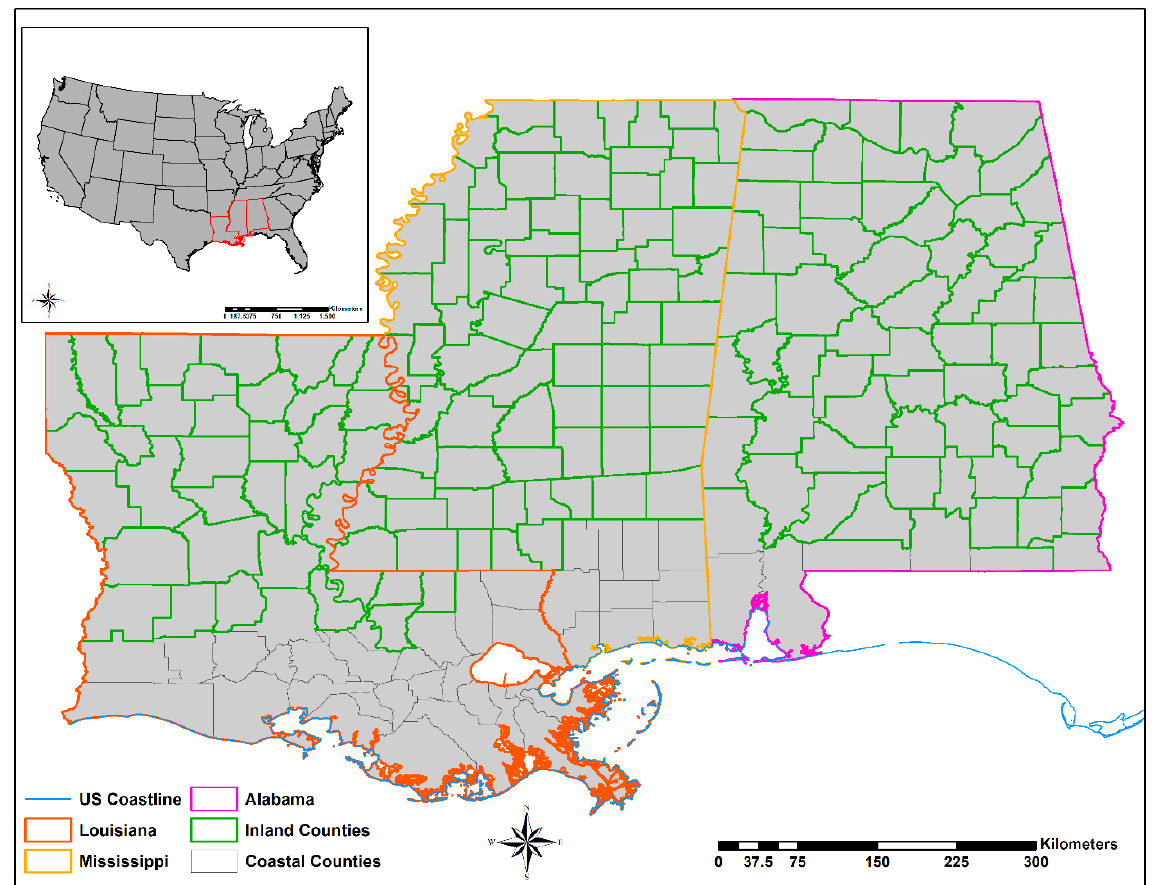
Figure 1. Inland counties in the study area along with the U.S. coastline.